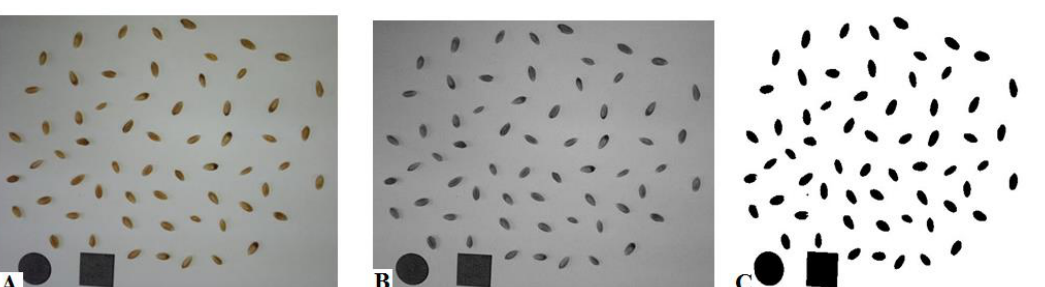
Fig. 1. Basic steps of measuring the grain's geometric properties using image processing.